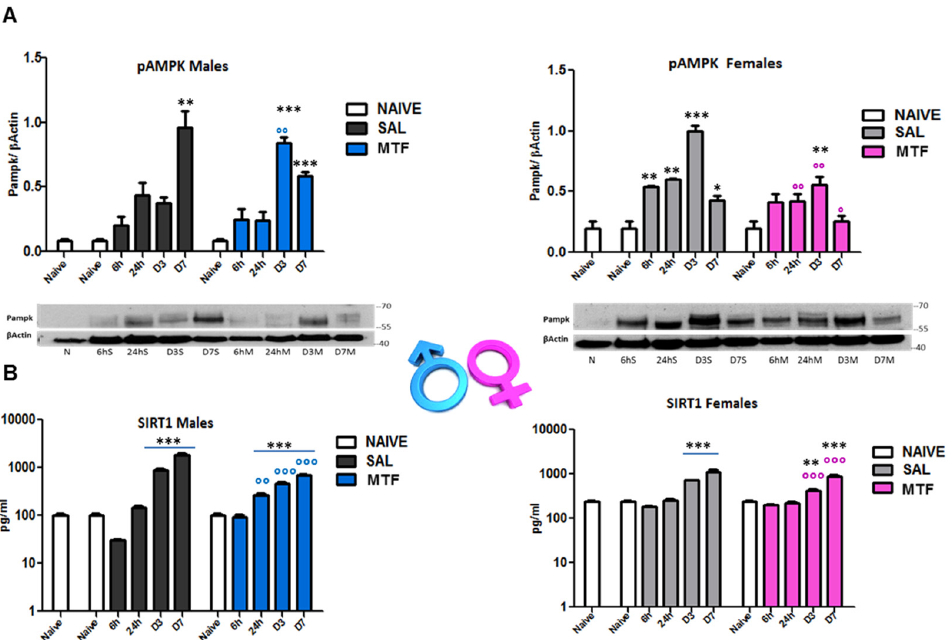
Figure 3. Effects of MTF administration on pAMPK and SIRT1 activation in the injured sciatic nerve. ( A ) pAMPK western blot analysis of male and female sciatic nerve lysates of naive sciatic nerves and nerves evaluated at different time points from the lesion (6 h–6 h, 24 h, day 3–D3, D7). ( B ) SIRT1 ELISA analysis of sciatic nerve lysates of naive sciatic nerves and nerves evaluated at different time points from the lesion (6 h–6 h, 24 h, day 3–D3, D7). T-student comparison: *, **, *** p < 0.05, 0.005, 0.0001 respectively vs. naive; °, °°, °°° (blue or pink) p < 0.05, 0.005, 0.0001 respectively vs. saline (SAL) males or females; n =3/4 animals/group. Kruskal–Wallis: pAMPK (males) H 8,9 : 21,73 p : 0.0054; pAMPK (females) H 8,9 : 22,529 p = 0.004; SIRT1 (males) H 9,10 : 25.59 p = 0.0024; SIRT1 (females) H 12,13 : 31,367 p = 0.0017.